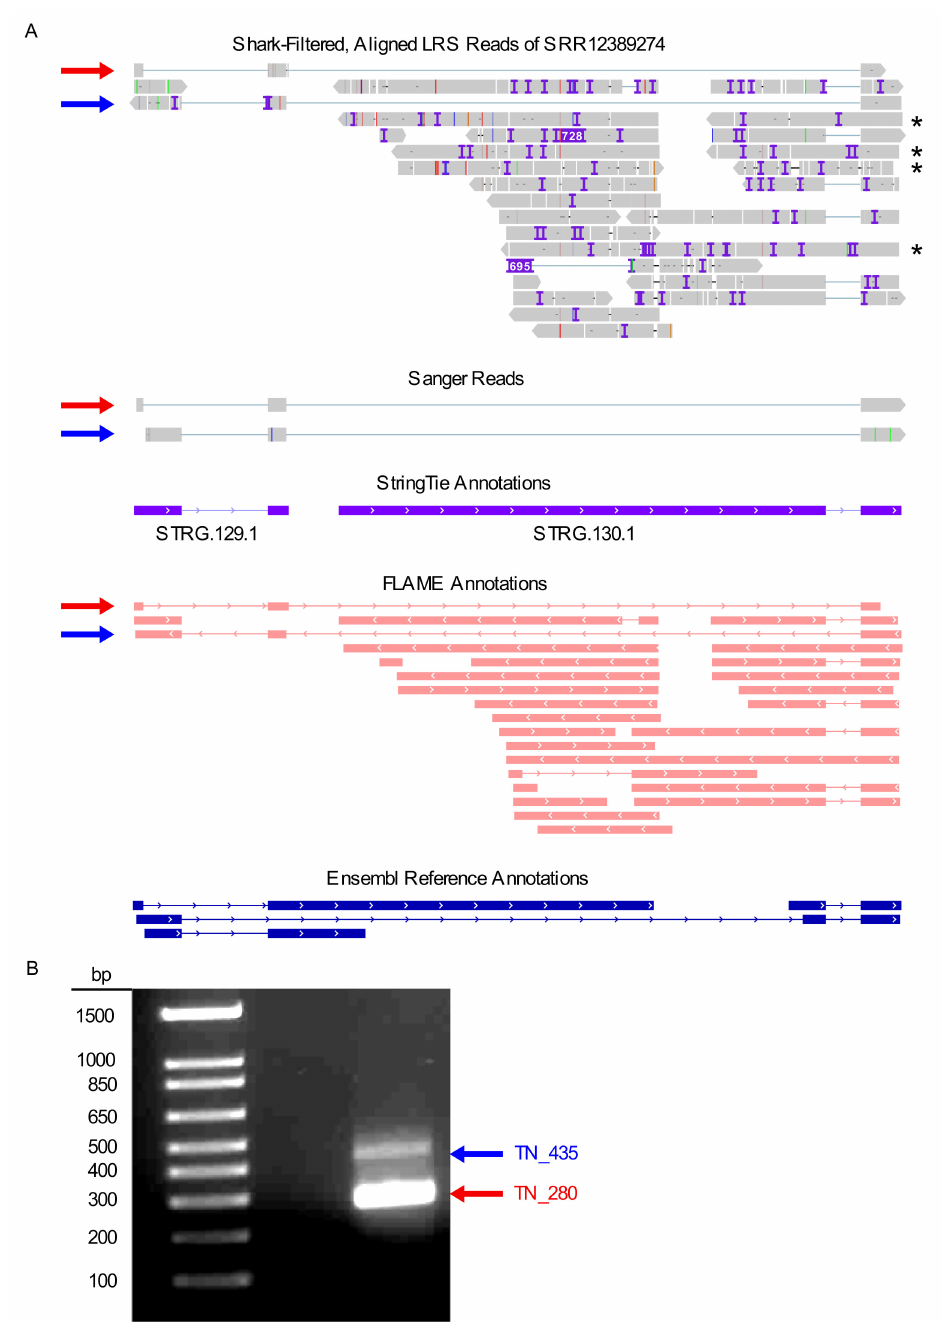
Figure 3. L-RAPiT identifies novel transcript variants at the LINC00173 locus in the use-case sam- ple. ( A ) Visualization of L-RAPiT output for the use case at the LINC00173 locus. From top to bottom: reads filtered by Shark, aligned by minimap2, and compressed and indexed by SAMtools (asterisks indicate reads with retained introns); experimental validation of TN_280 and TN_485 sequences, obtained by PCR and subsequent Sanger sequencing (note that TN_280 was sequenced from both ends, whereas TN_485 was only sequenced from the 5 (cid:48) end, resulting in a truncated 5 (cid:48) sequence); StringTie-generated de novo annotation of the LRS alignment; FLAME-generated comparison of the LRS alignment with the reference annotation (salmon color indicates no matching transcript in the reference); and the reference transcripts currently annotated in Ensembl. Image generated with IGV. ( B ) Gel image of PCR-amplified transcripts TN_280 and TN_435. Ladder in the first lane indicates size in bp. Throughout the figure, red arrows indicate TN_280; blue arrows indicate